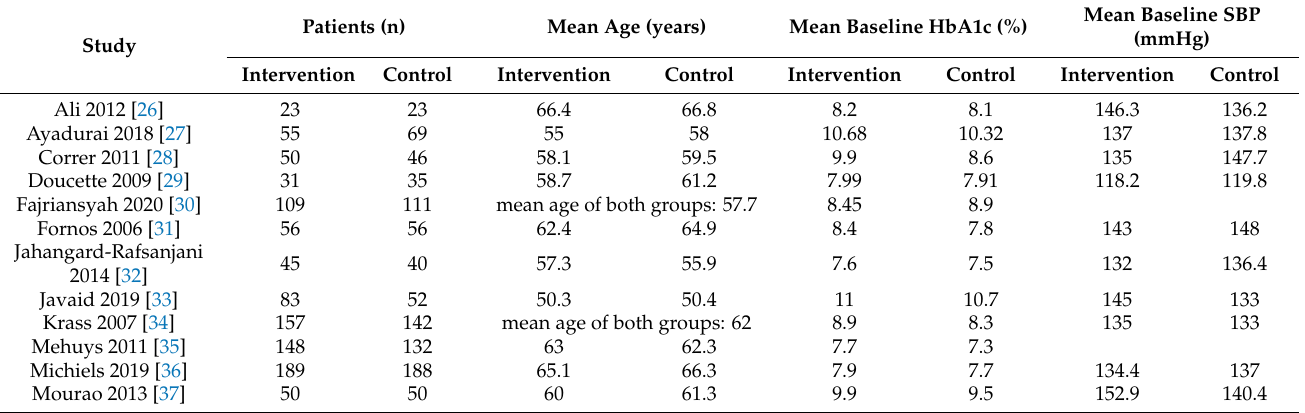
Table 2. Patients